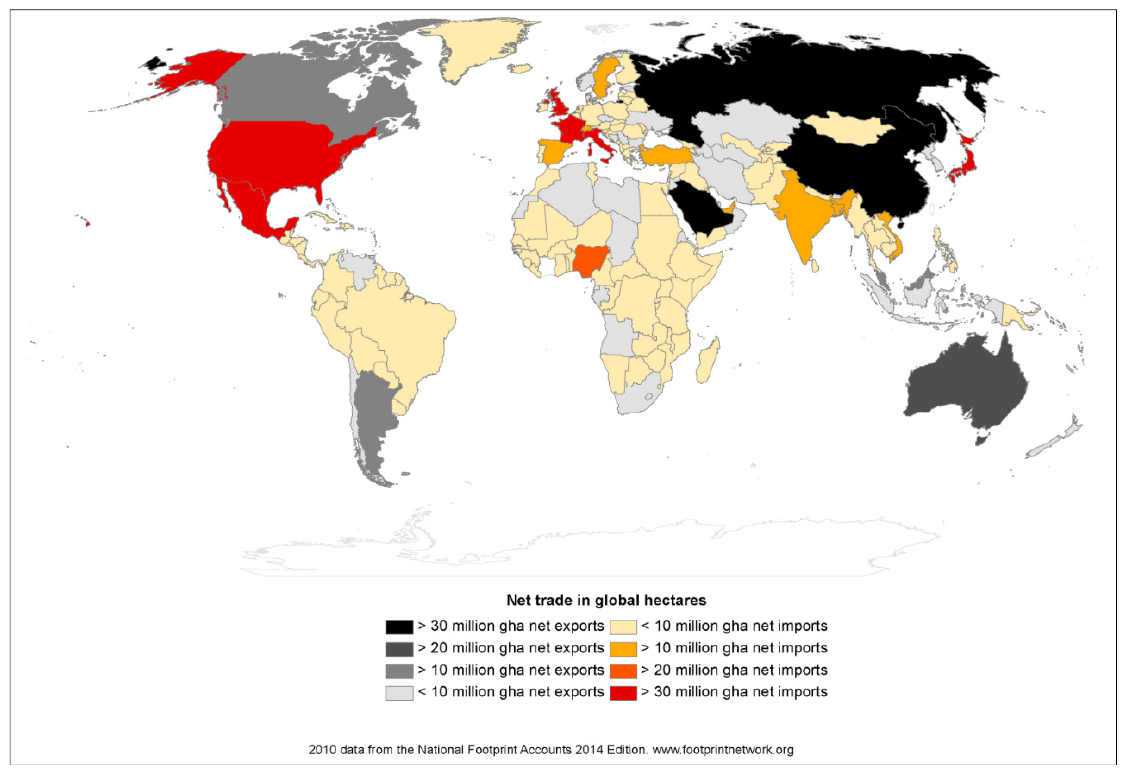
Figure 2. Net trade in the embodied carbon